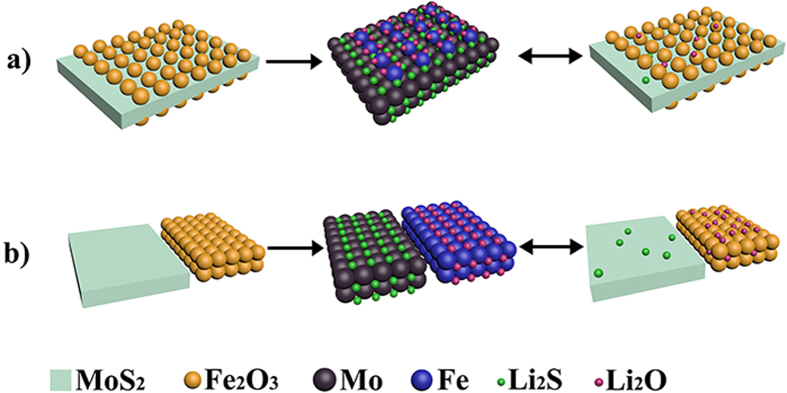
(a) Schematic illustration of the irreversible Li2O converse to Li+ for the Fe2O3/MoS2 composite. Due to high electrochemical activity of Mo metal clusters and efficient contact between Mo metal clusters and the irreversible Li2O, the irreversible Li2O can converse to Li+ after the charging process, and (b) Schematic illustration of the irreversible Li2O converse to Li+ for the physical mixture Fe2O3+MoS2. The conversion of the irreversible Li2O to Li+ will be greatly suppressed because the efficient contact between Mo and Li2O is more difficultly available.